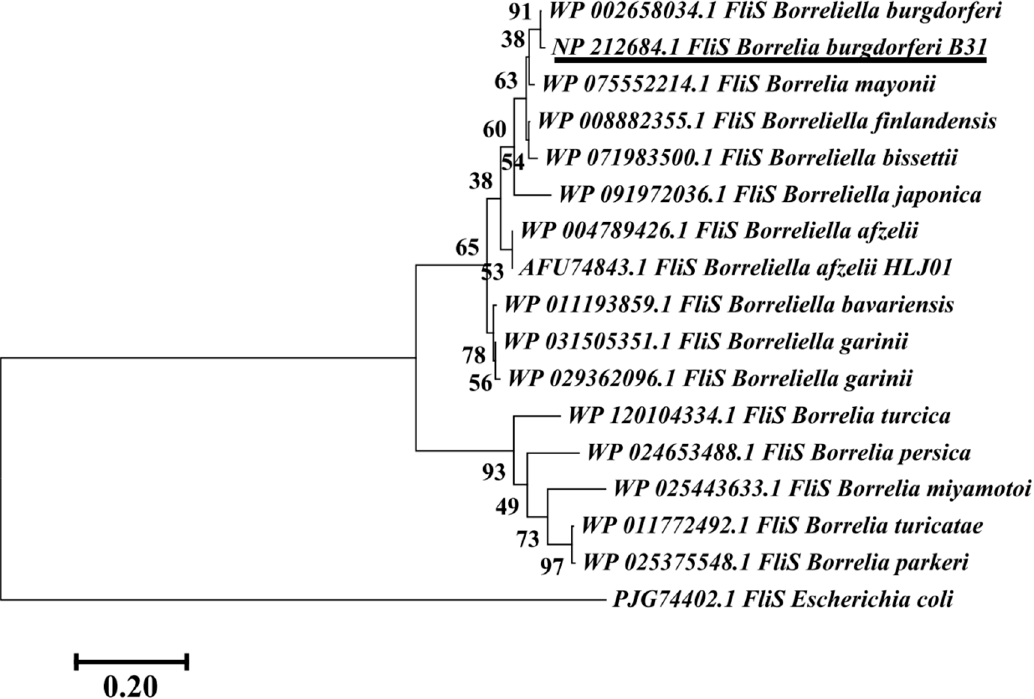
Figure 3. The neighbor-joining tree was constructed for the amino acid sequence of vaccine candidates of B. burgdorferi B31 protein. The target sequence of the vaccine candidate is underlined and support values (bootstrapping values) are indicated at each node. Species names are followed by accession number and the outgroup used to root the tree was Escherichia coli FliS sequence. The bar represents 0.20 substitutions per site.